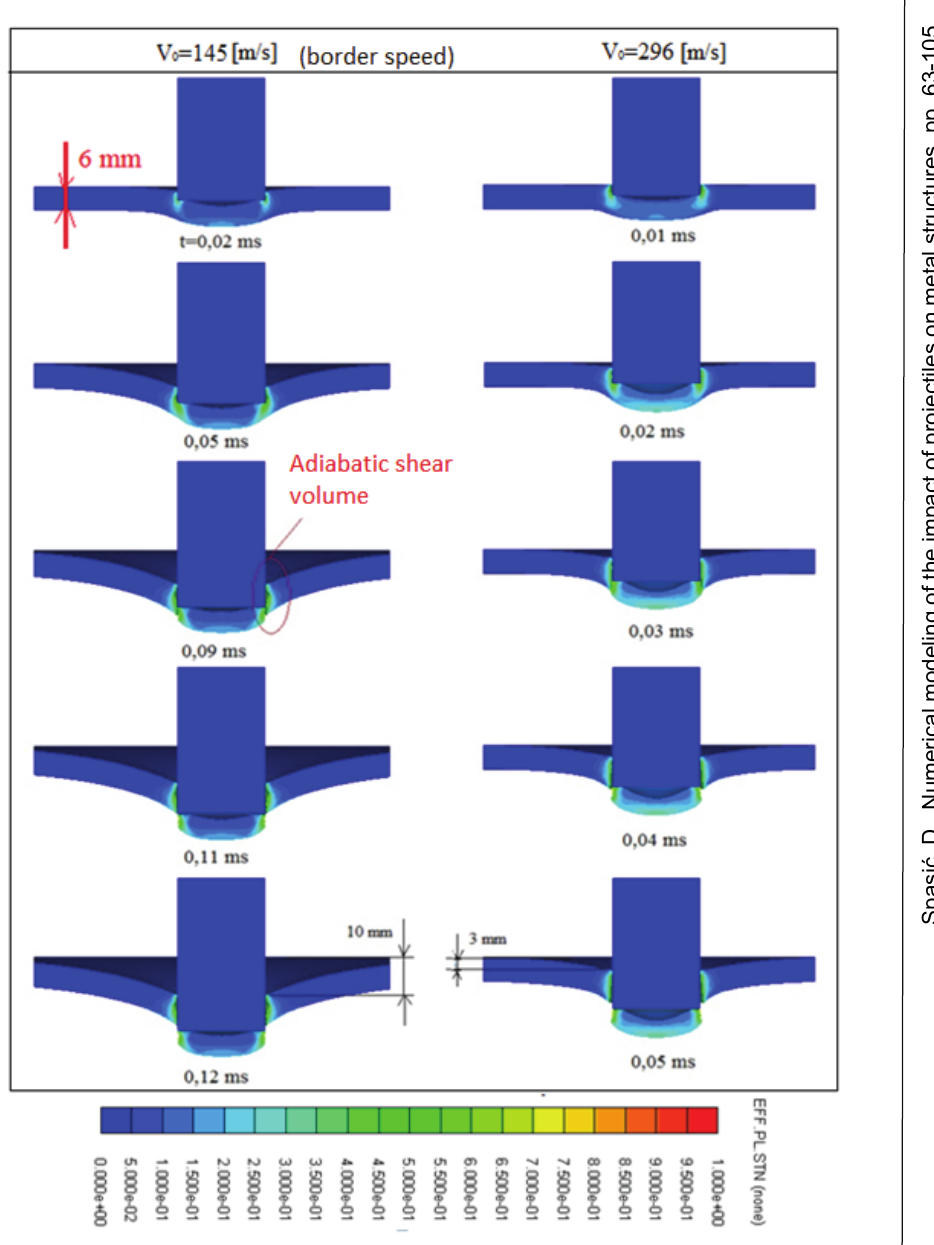
Figure 35 – Comparison of blunt projectile penetration through a 6mm-thick steel plate at two speeds, Vo=145 m/s and Vo=296 m/s, FEM